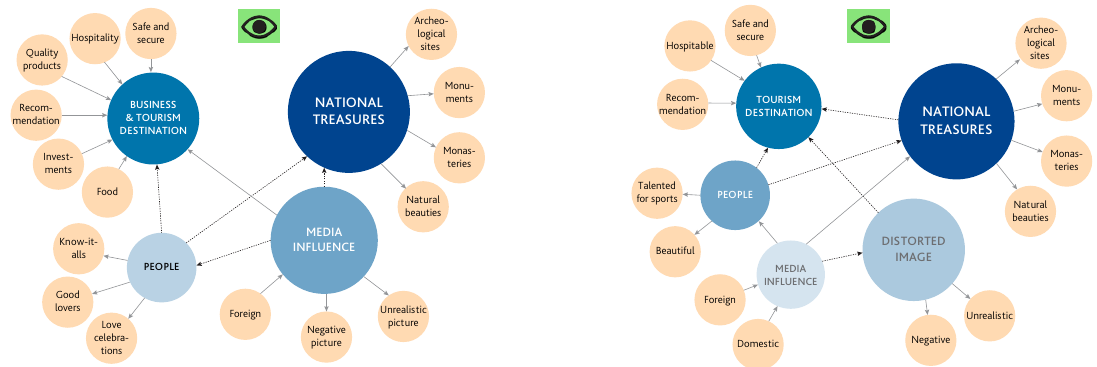
Figure 2. Serbia brand identity models